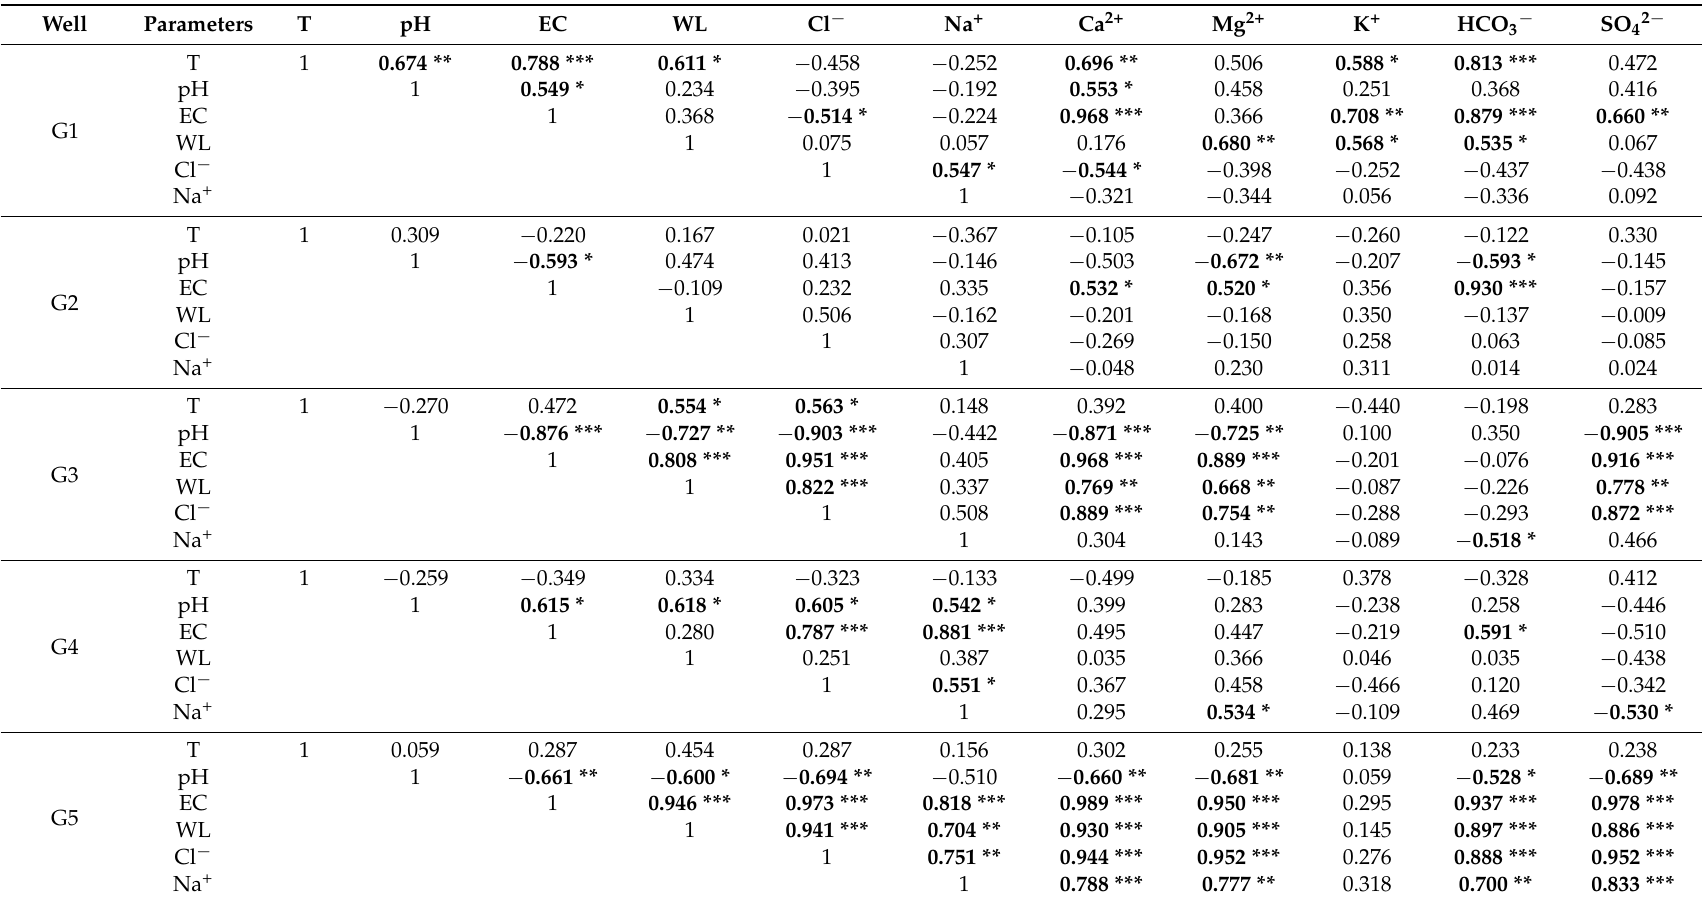
Table 1. Pearson’s correlation coefficients among groundwater parameters at each